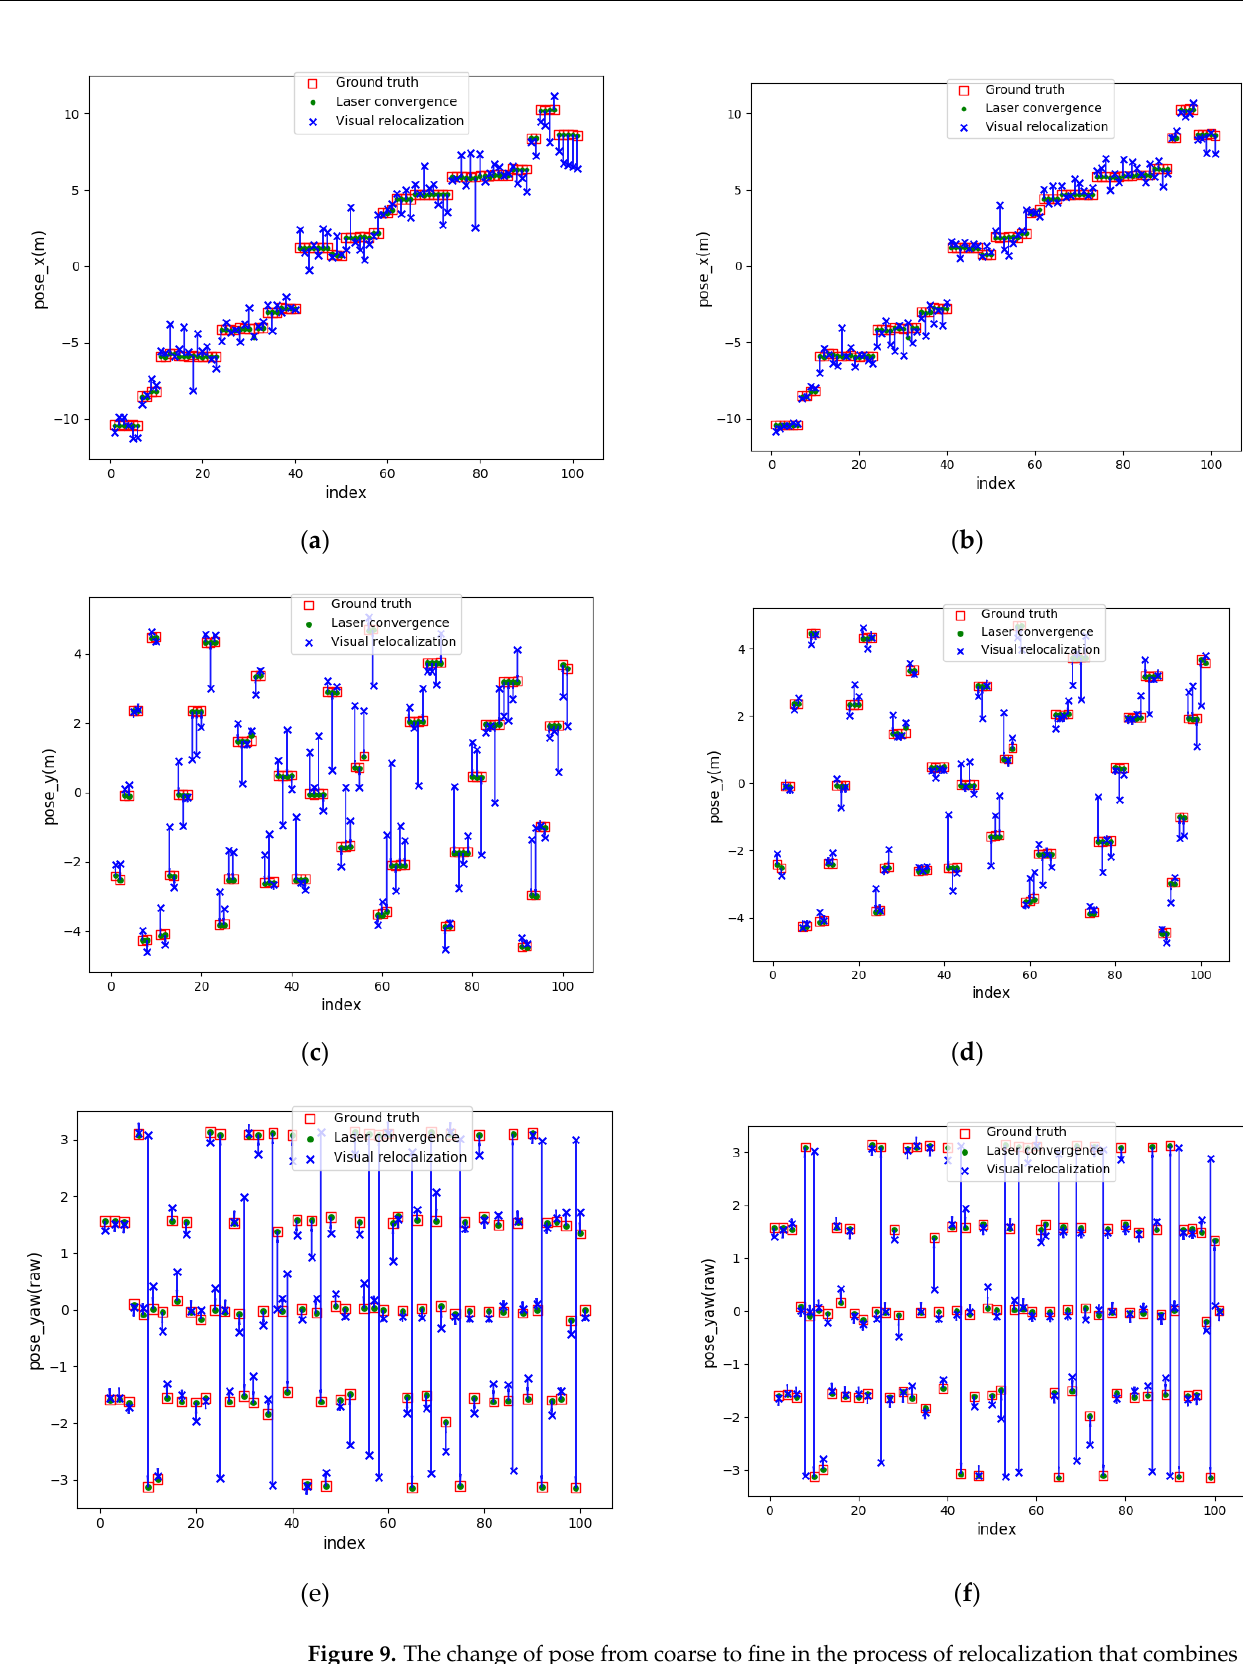
Figure 9. The change of pose from coarse to fine in the process of relocalization that combines laser and visual information. ( a , c , e ) The pose change in the x , y , and yaw directions, respectively, when using the posenetLSTM method; ( b , d , f ) The pose change in the x , y , and yaw directions, respectively, when using the method proposed in this